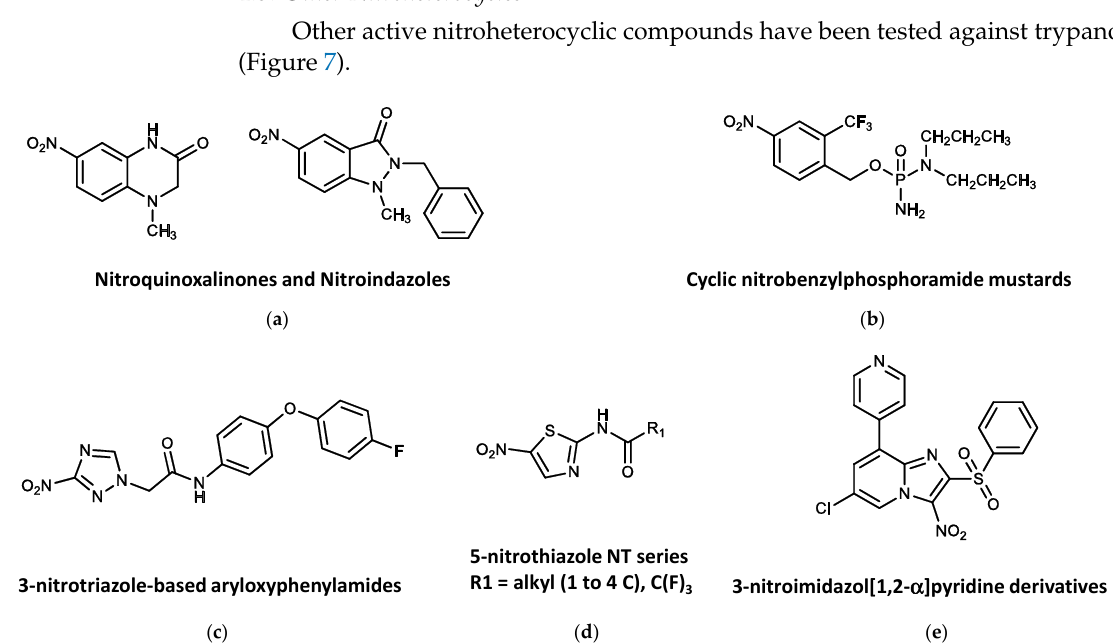
Figure 7. Other active nitroheterocyclic compounds tested against trypanosomatids. ( a ) Nitroquinoxalinones and Nitroindazoles. ( b ) Cyclic nitrobenzylphosphoramide mustards. ( c ) 3-nitrotriazole-based aryloxyphenylamides. ( d ) 5-nitrothiazole NT series. ( e ) 3-nitroimidazol [1,2- α ] pyridine derivatives.